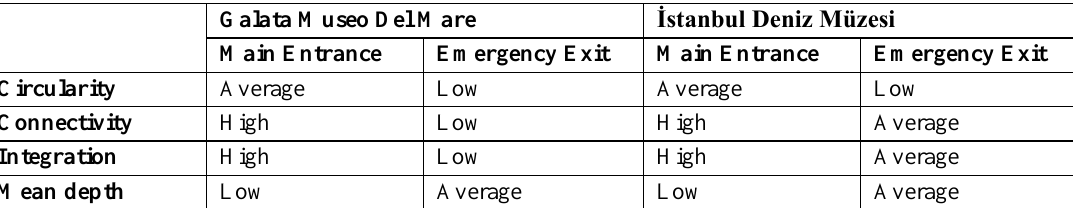
Table 4 Evaluation of space syntax